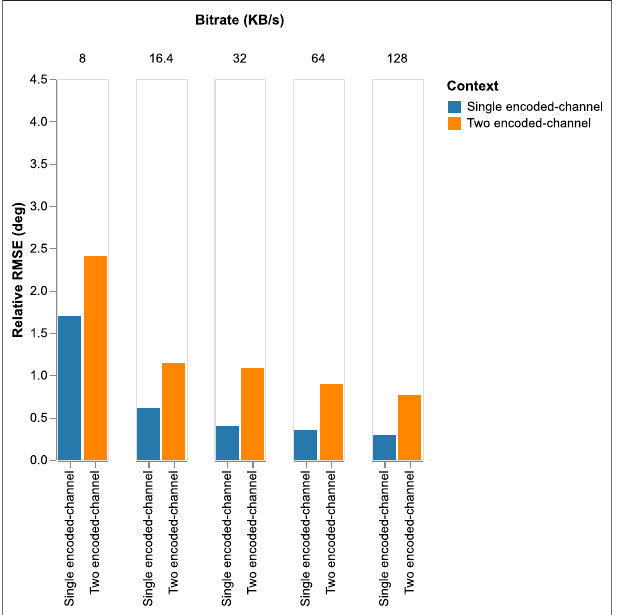
FIGURE 13 | Relative RMSE degradation for a varying bitrate performed for the two models: 1) Single encoded-channel model where one of the channels is without compression and the second is encoded with Opus. 2) The two encoded-channel model where the two inputs are encoded similarly with Opus at a varying bitrate.